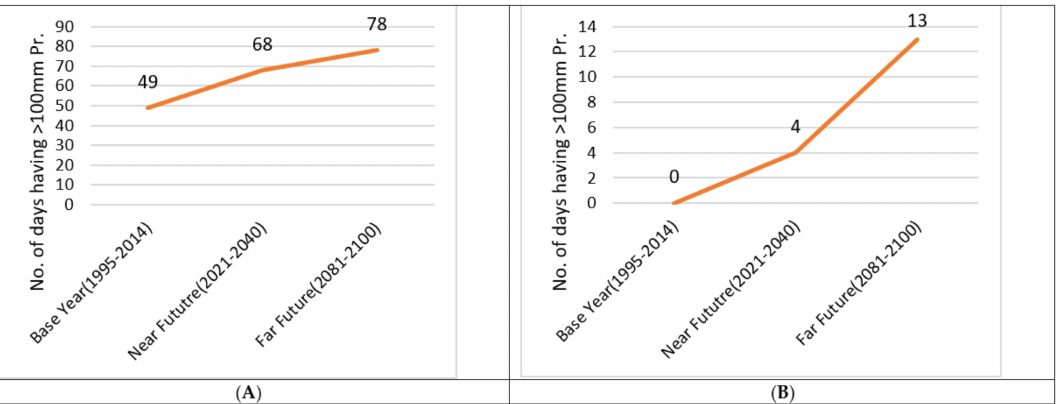
Figure 5. Number of days having greater than 100 mm precipitation ( A ) from the BCC-CSM2-MR model and ( B ) from the MRI-ESM2-0